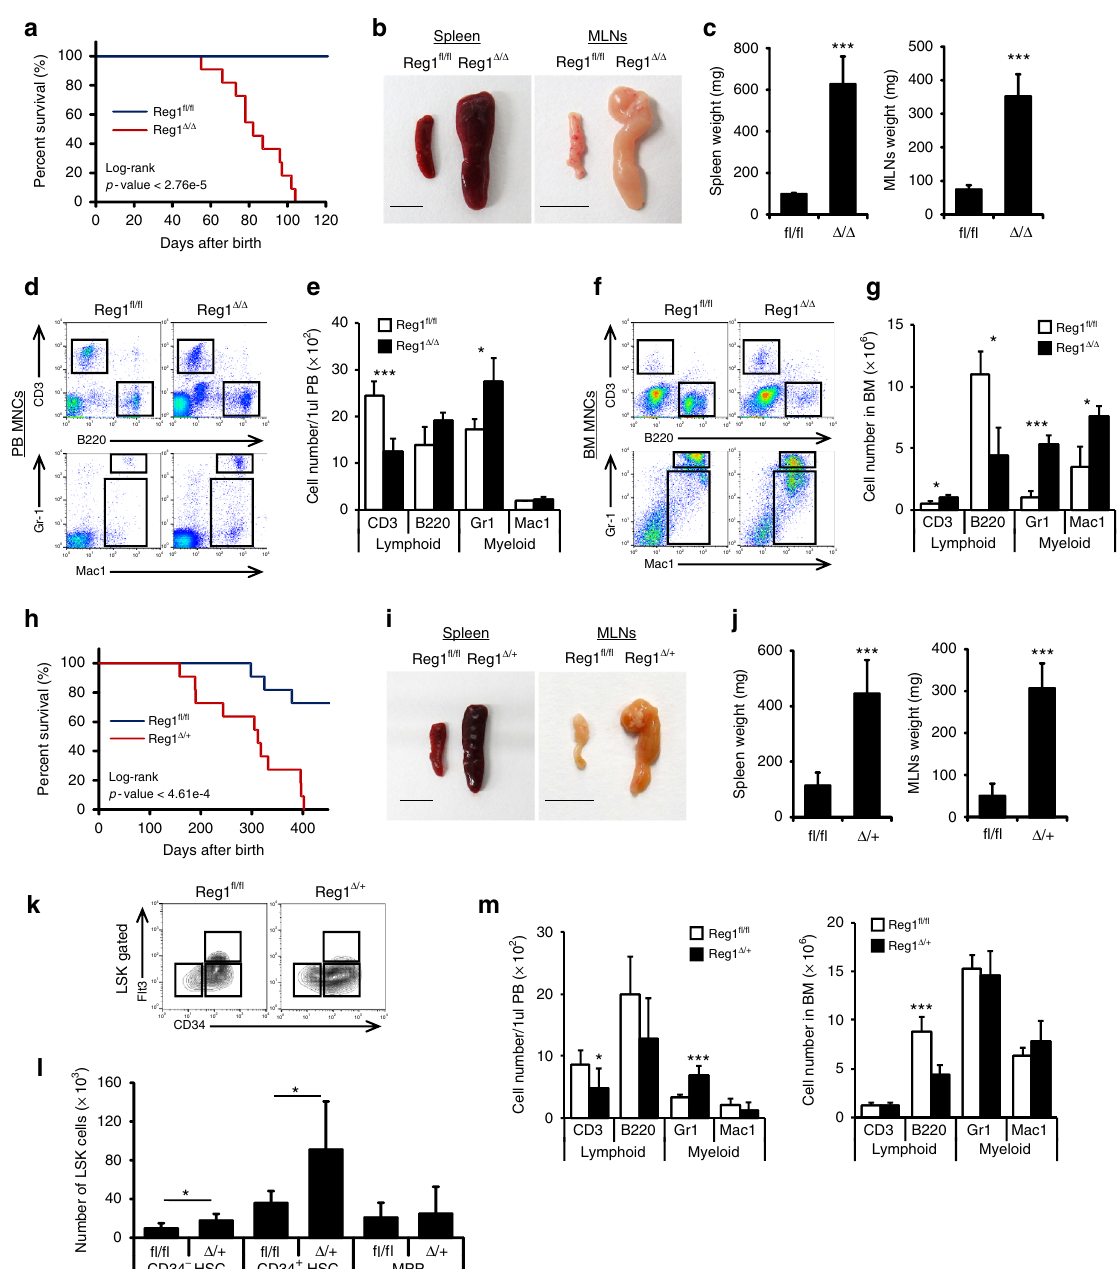
Fig. 4 Loss of Regnase1 causes impaired hematopoietic functions. a Kaplan-Meier survival curve of control ( fl / fl ) and Regnase-1-KO ( Δ / Δ ) mice ( n = 11). P values were calculated by the logrank test. b Representative gross appearance of the spleen and mesenteric lymph nodes (MLNs) collected from 8-week- old mice as indicated. The scale bars represent 1 cm. c Spleen (right) and MLNs (left) weight of 8-week-old mice as indicated ( n = 4 per group). d Flow cytometric analysis of lymphocytes and monocytes in PBMCs from 8-week-old mice as indicated ( n = 3 per group; 3 independent experiments). e Quanti fi cation of frequencies of lymphoid and myeloid cells in PBMCs. f Flow cytometric analysis of lymphocytes and monocytes in BM MNCs from 8- week-old mice as indicated ( n = 3 per group; 3 independent experiments). g Quanti fi cation of frequencies of lymphoid and myeloid cells in bone marrow MNCs. h Kaplan-Meier survival curve of control ( fl / fl ) and Regnase-1 hetero-mutant ( fl / Δ ) mice ( n = 11). P values were calculated by the logrank test. i Representative images of the spleen and MLNs collected from 12-month-old mice as indicated. The scale bars represent 1 cm. j Spleen (right) and MLNs (left) weight of 12-month-old mice as indicated ( n = 4 per group). k , l Representative fl ow cytometric analysis and quantitative evaluation of LSK-HSC numbers in the BM of 8-week-old mice as indicated ( n = 3 per group; 3 independent experiments). m Quanti fi cation of ratios of lymphocytes and monocytes in PB (left) and BM (right) MNCs from 12-month-old mice as indicated ( n = 3 per group; 3 independent experiments). The ratio was calculated by fl ow cytometric analysis. Error bars indicate mean ± SD. * p < 0.05; ** p < 0.01, *** p < 0.005, logrank test in h , two-sided t -test in c , e , g , j , m , hematopoiesis by promoting mutagenesis. Collectively, our data Regnase-1 targets the 3 ′ UTR of mRNAs encoding Gata2 and reveal a role for Regnase-1 in regulating HSPC proliferation in Tal1 , and post-transcriptionally modulates their activity through hematopoietic homeostasis, the dysfunction of which could lead mRNA degradation. Excessive proliferation of HSPC resulting to the generation of leukemic cells. from Regnase-1 de fi ciency may allow progression to abnormal